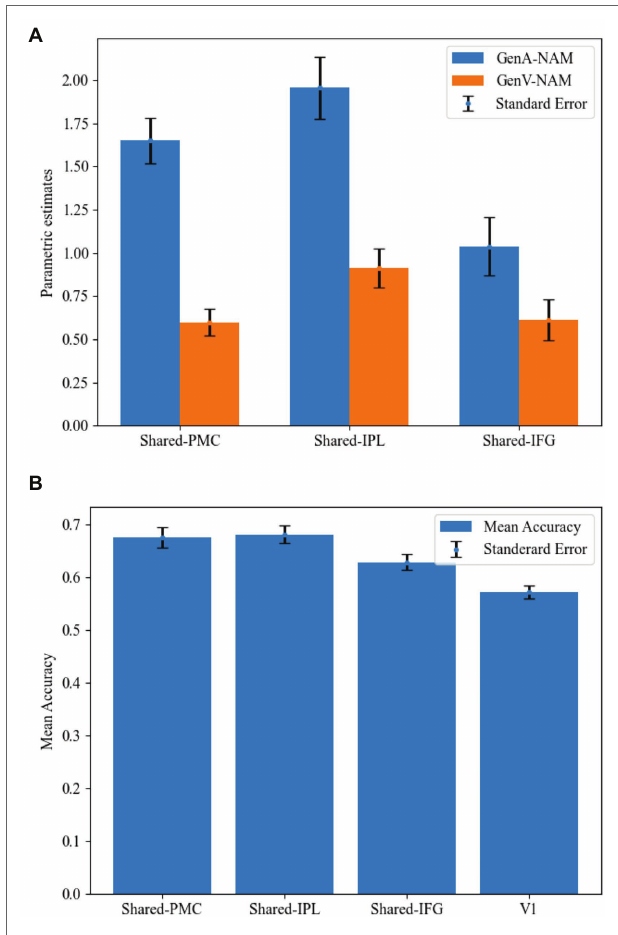
FIGURE 5 | Comparisons between the GenA and GenV tasks in the shared regions. (A) Estimated parameters for GenA-NAM and GenV-NAM conditions. (B) The classification accuracy in each shared region and the